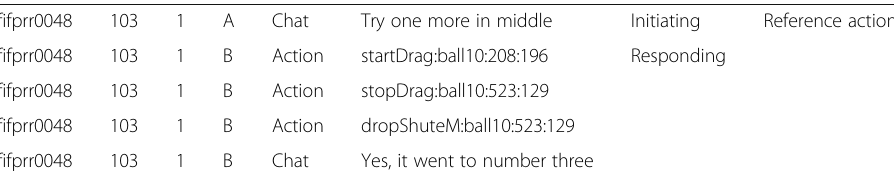
Table 3 Example of the coded log data as initiating and reference-action sequence